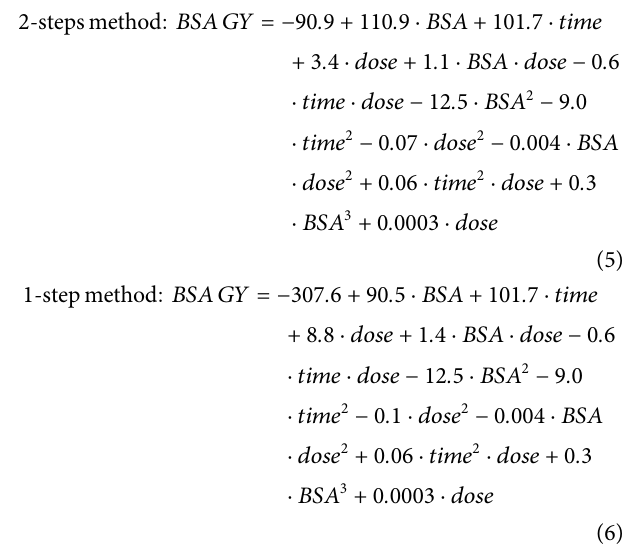
Frontiers in Chemistry |